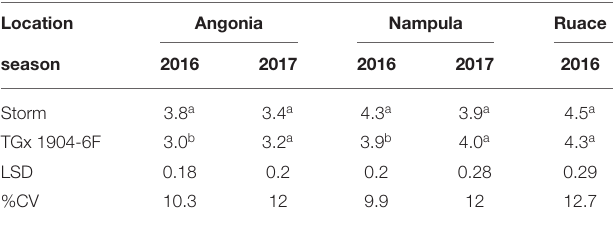
TABLE 4 | Site nodule weight (plant − 1 ) in the 2016 and 2017 growing seasons. Inoculant